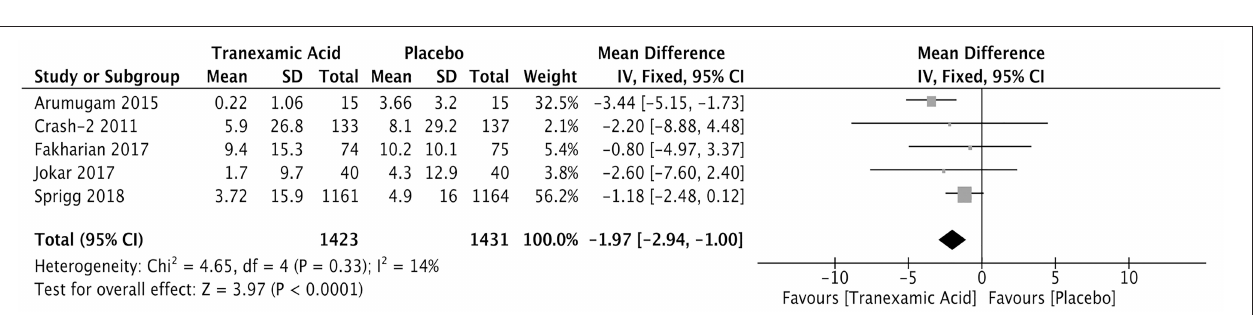
FIGURE 3 | Forest plot of the comparison between tranexamic acid and placebo treatments for the volume of hemorrhagic lesion.